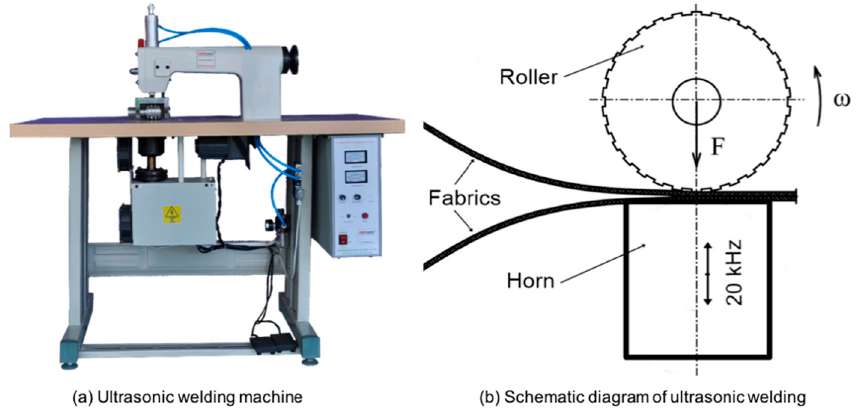
Figure 2. Ultrasonic welding equipment and schematic diagram. ( a ) Ultrasonic welding machine, ( b ) Schematic diagram of ultrasonic welding.